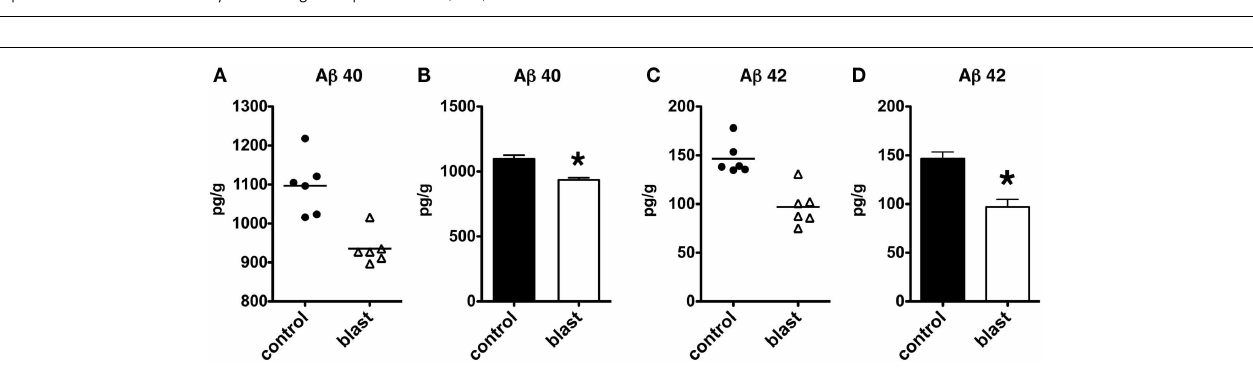
FIGURE 7 |Western blotting was performed on hemi brain SDS extracts from sham exposed (controls) or rats exposed to 36.6kPa blast injury harvested at 24h (A) or 1week post-blast exposure (B). Blotting was performed with an antibody that recognizes presenilin-1 (PS1) and the blots